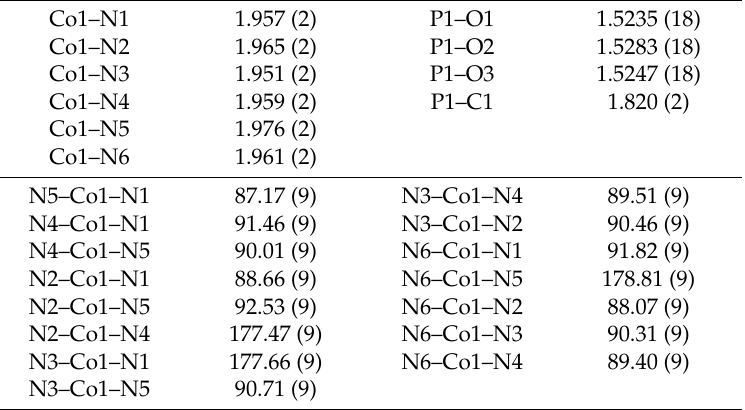
Table 3. Selected bond lengths and angles (Å, ˝ ) in 2 .